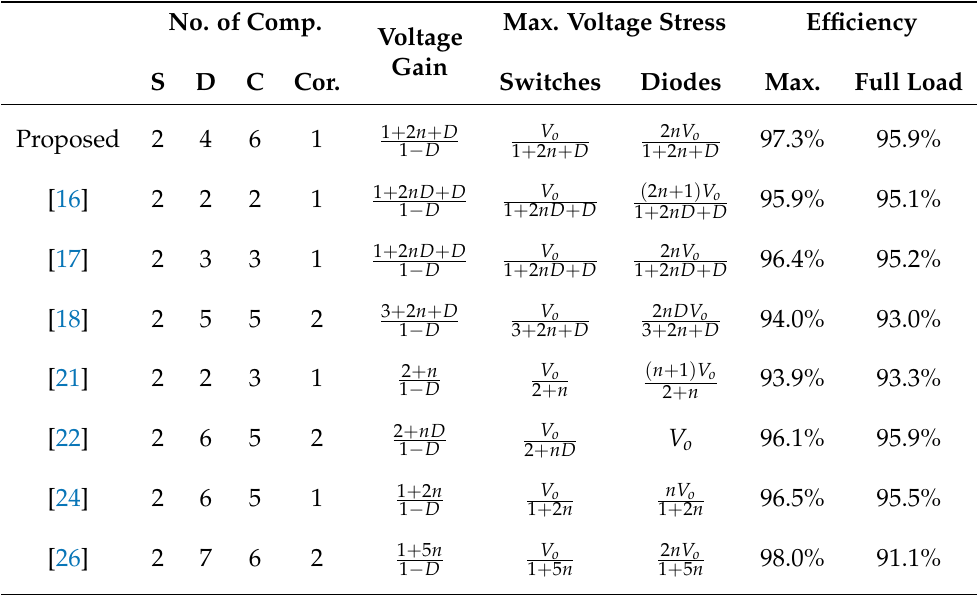
Table 1. Performance comparison between the proposed converter and other recently pro- posed